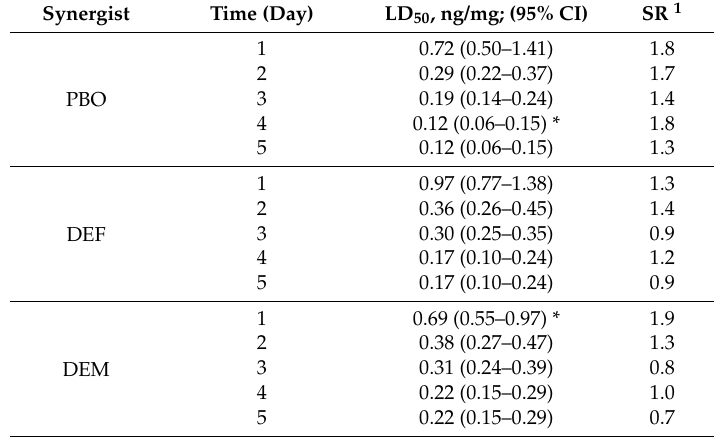
Table 5. Effects of synergists in topical assays of fluralaner against Ae. aegypti adult